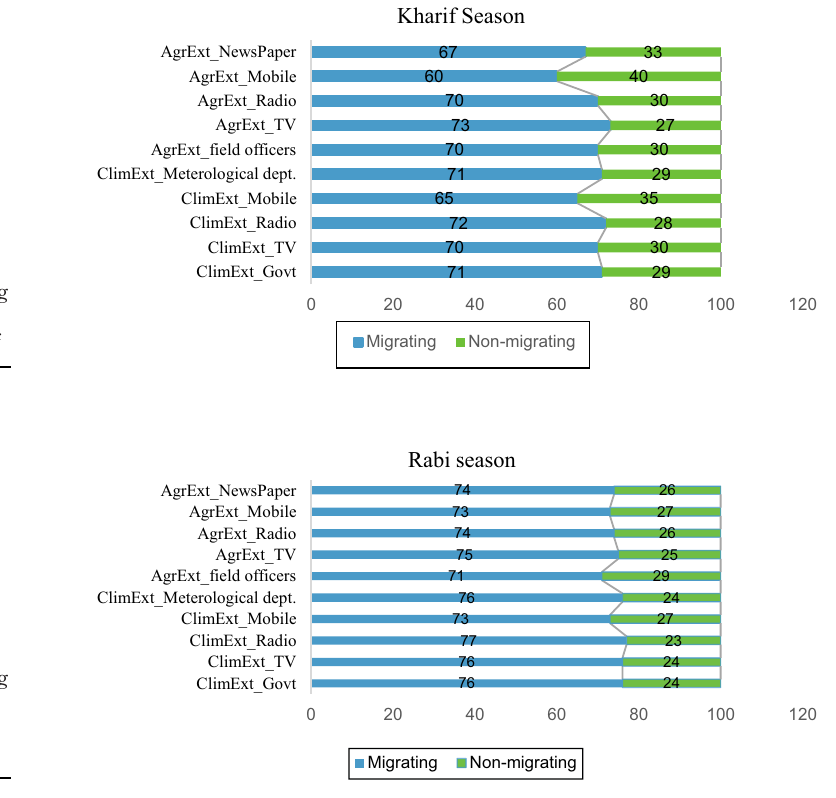
Figure 1. Choice of extension